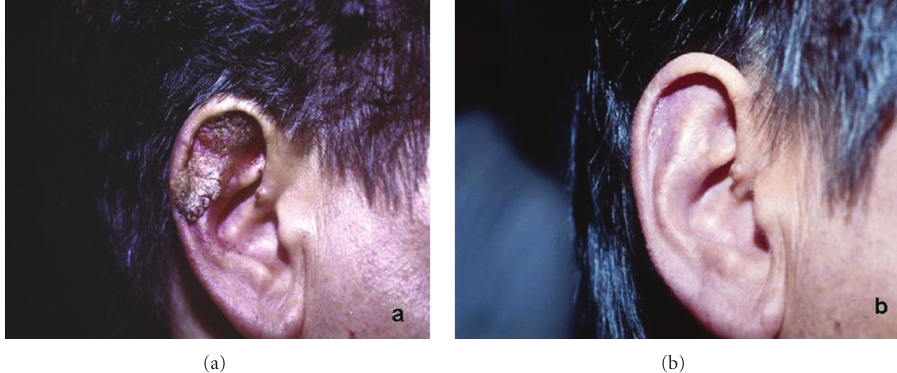
Figure 7: Vulgar warts at first (a) and after one (b) treatment with CO 2